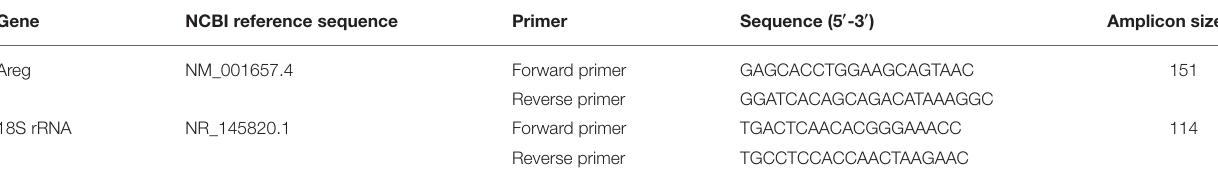
TABLE 2 | List of forward and reverse primers for each of the genes assessed by qRT-PCR. Gene